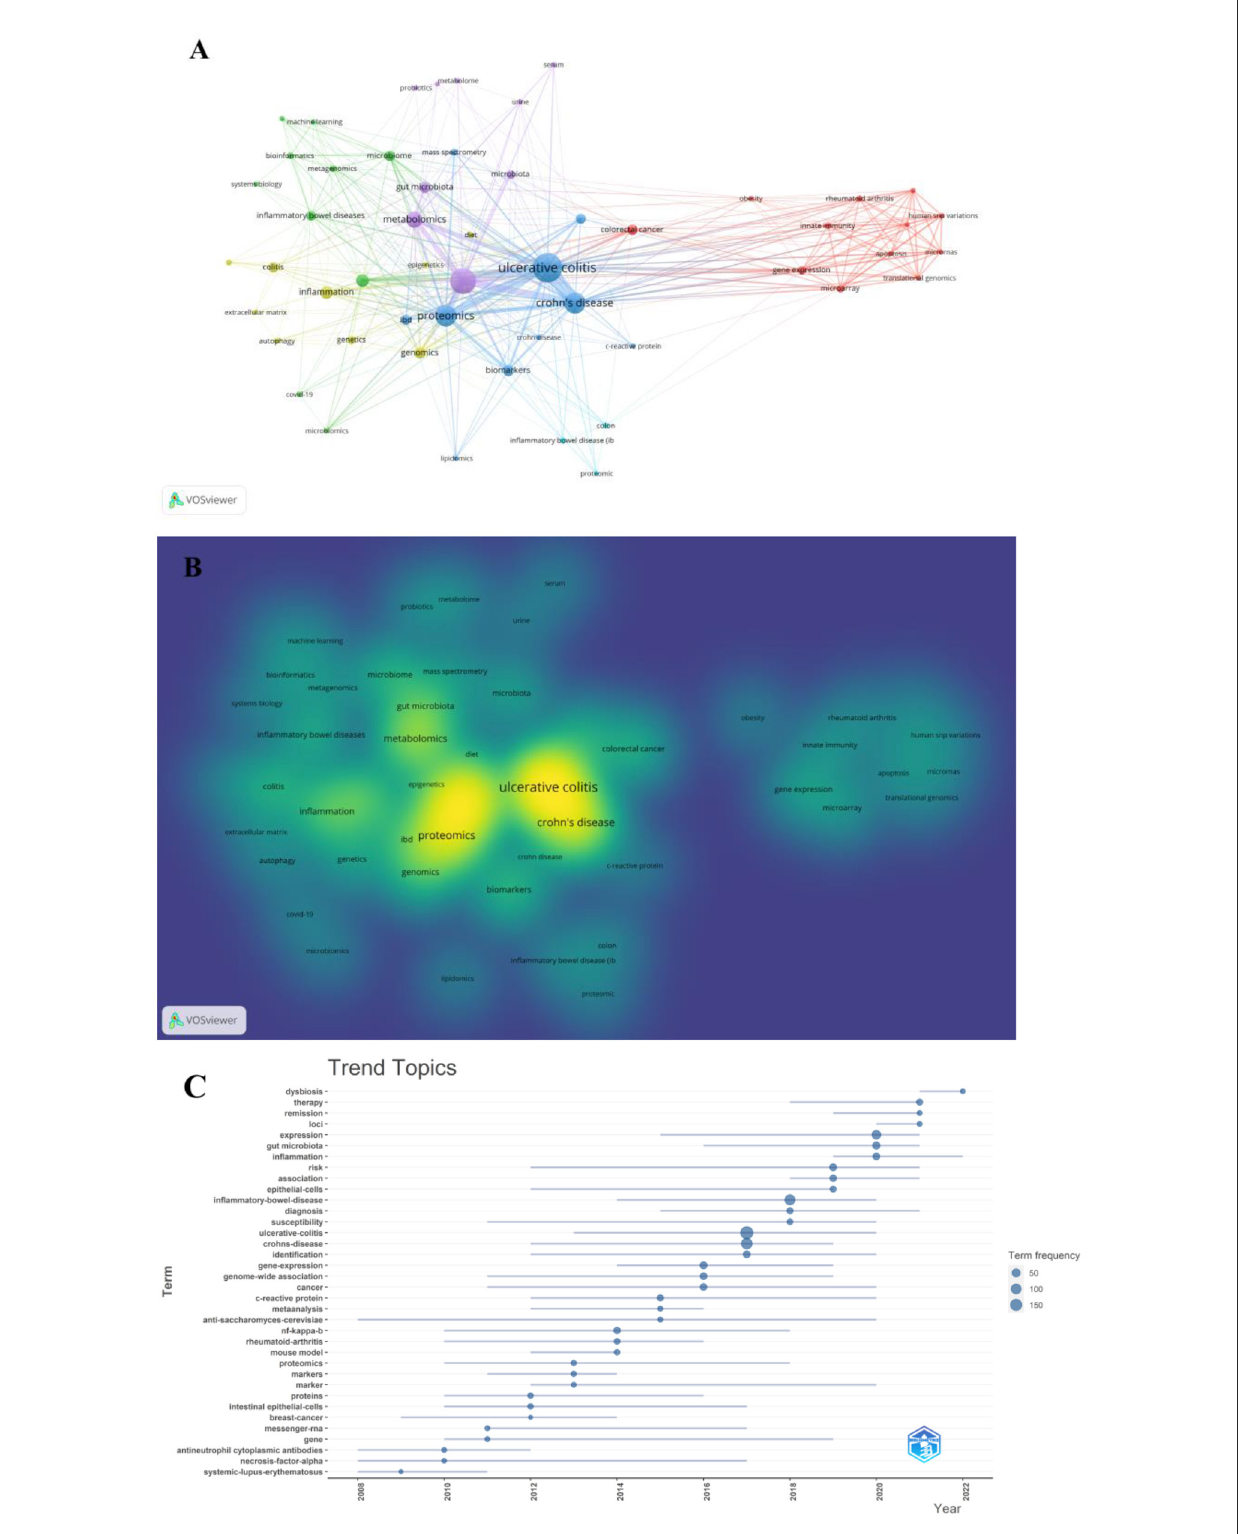
FIGURE8 (A) Network of keyword on research of omics in UC. (B) Density map of keyword on research of omics in UC. (C) Trend topics.